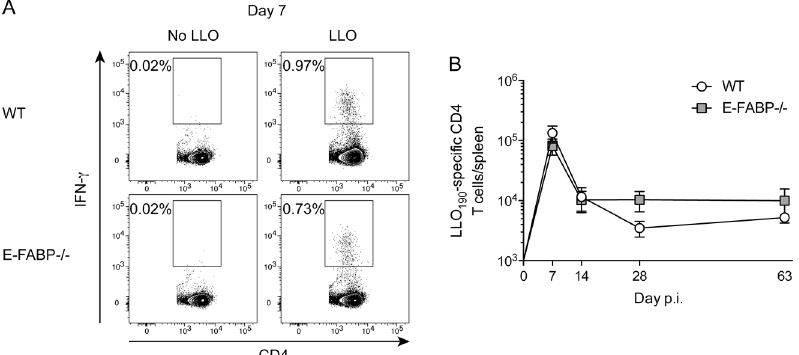
Fig 3. Kinetics of Listeria -specific CD4 T cells in WT and E-FABP-deficient mice. WT and E-FABP-/- mice were infected with 5x10 6 Lm-OVA. (A) Representative contour plots showing the frequency of LLO- specific CD4 T cells as detected by peptide (LLO 190-201 ) stimulated intracellular cytokine staining for IFN- γ at the indicated days following infection with Lm-OVA. (B) Total number of LLO-specific CD4 T cells in the spleen. Data (mean ± s.d.) are from 3-mice/time point/group except day 63 WT (n = 2). Data are representative of two independent experiments and were analyzed by the Mann-Whitney